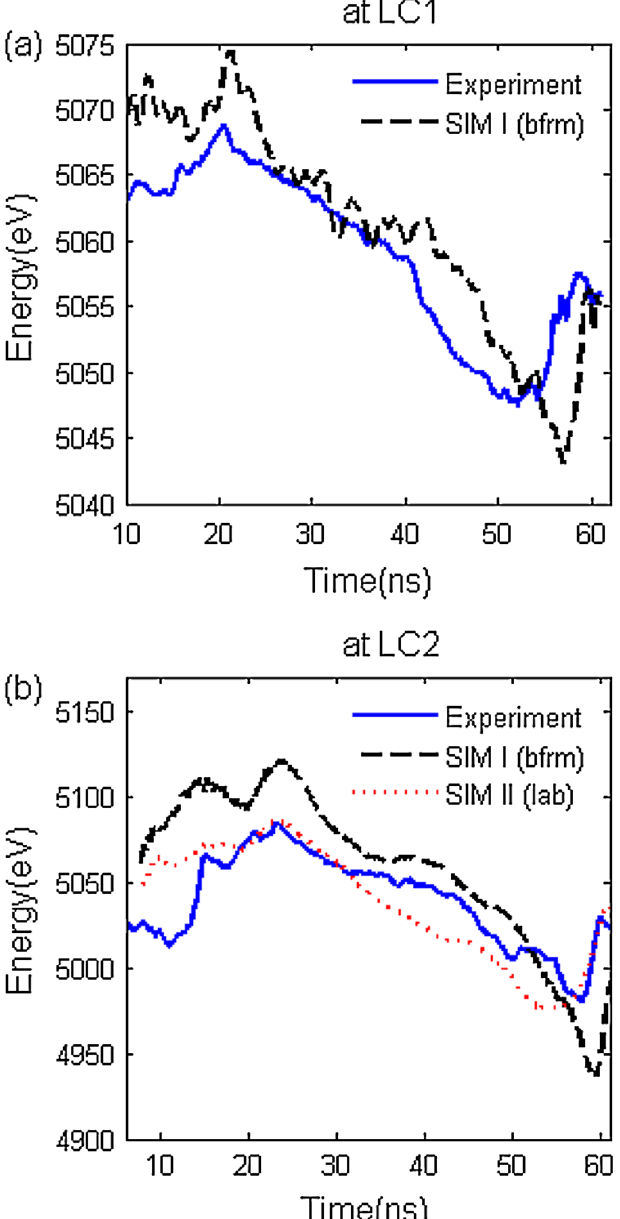
FIG. 7. (Color) Comparison of mean energy profiles of the 23 mA parabolic beam between the experimental results, WARP simulations in the beam frame and lab frame: (a) at LC1; (b) at